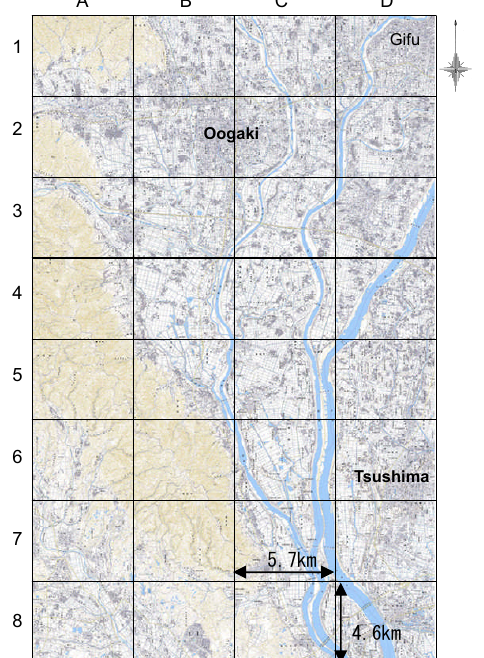
Figure 6. Analysis area.